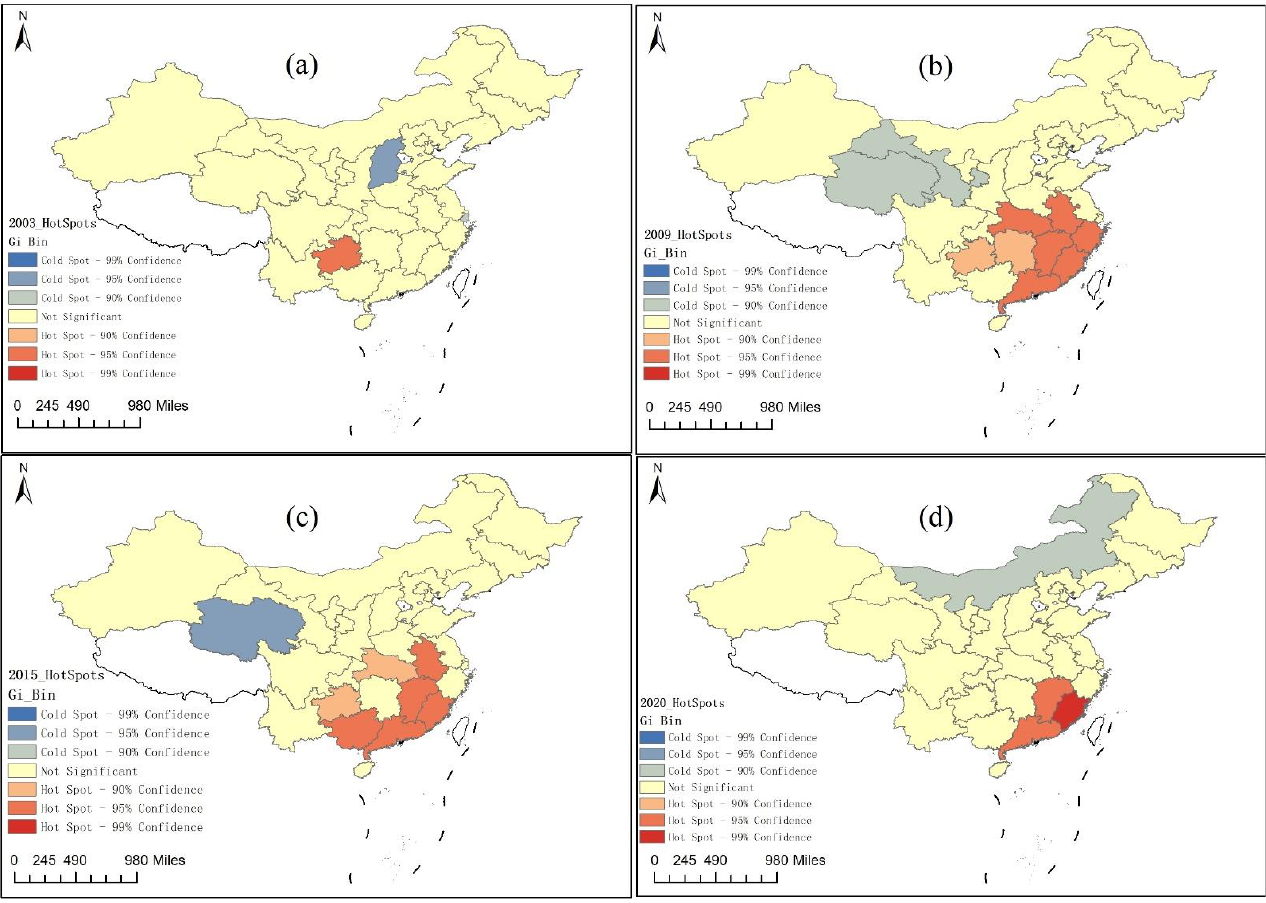
Figure 4. The spatial agglomerated evolutionary trend of hot – cold spot regions of the CCFE in the years 2003, 2009, 2015, and 2020, respectively. Note: (1) The symbol ( a – d ) refers to the green finance index, the ecological environment index, the coupling index between green finance and the ecological environment, and CCFE re-spectively.